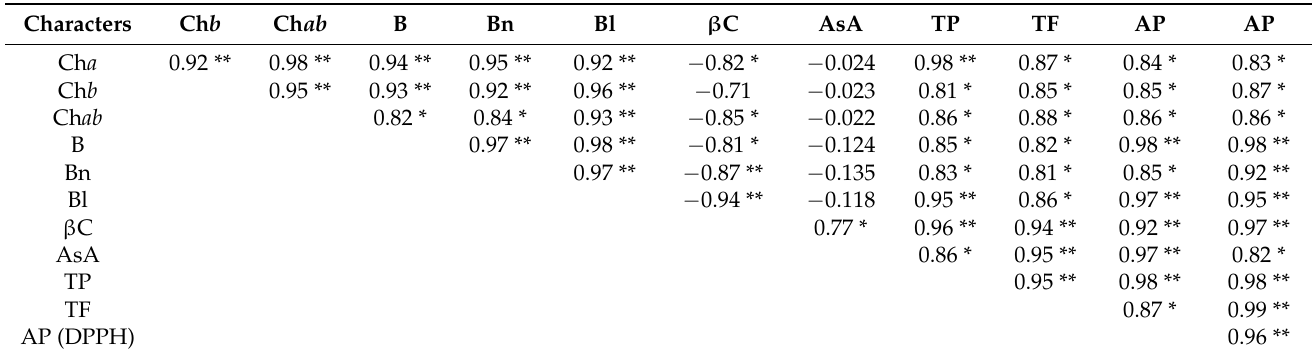
Table 1. The correlation coefficient for ascorbic acid, pigments, TP, β -carotene, AP (DPPH), TF, and AP (ABTS + ) in danta